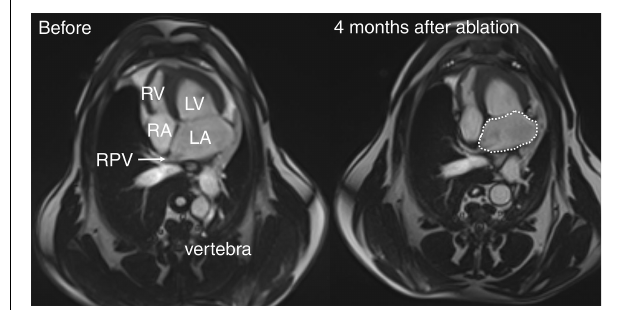
FIGURE 3 | Cardiac magnetic resonance (CMR) images of sheep. Transaxial CMR images of sheep heart with RPV before (left panel) and 4 months after (right panel) ablative energy delivery localized in the RPV. The dotted line denotes the LA surface area for volume estimation. LV, left ventricle; RA, right atrium; RV, right